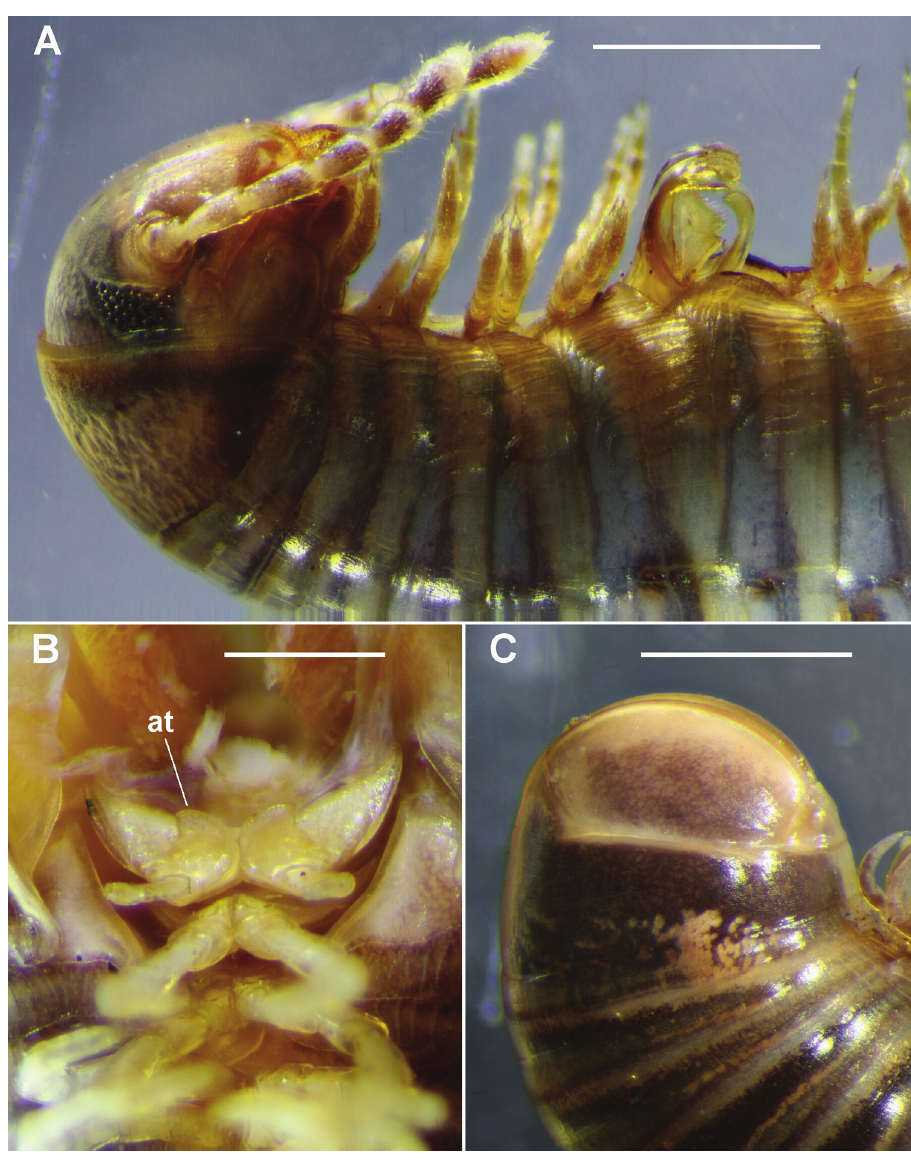
Figure 9. Atelomastix bonhami sp. n., males. A Left lateral view showing partly everted gonopods; QVM 23:54175 B Ventral view of partly dissected specimen showing legpair 1 in situ; at = anterior tab on prefemur; QVM 23:54174 C Left lateral view of telson; QVM 23:54140. Scale bars: A, C = 1.0 mm, B = 0.5 mm. and a non-bifurcate sclerite “c”. Differences between A. bonhami / A. gibsoni : rounded tab present under sclerite “a” near pseudoflagellum/no tab; anterior corner of distal margin of sclerite “b” higher than posterior corner/anterior corner lower than posterior corner; sclerite “c” taller than sclerite “b”/ sclerite “c” shorter than sclerite